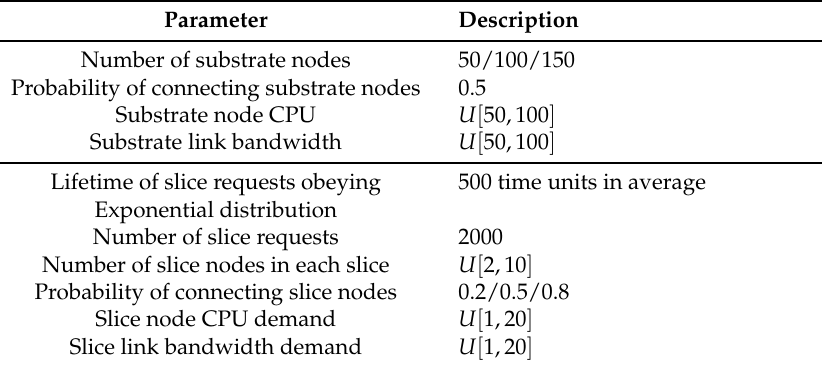
Table 2. Notations of system model.